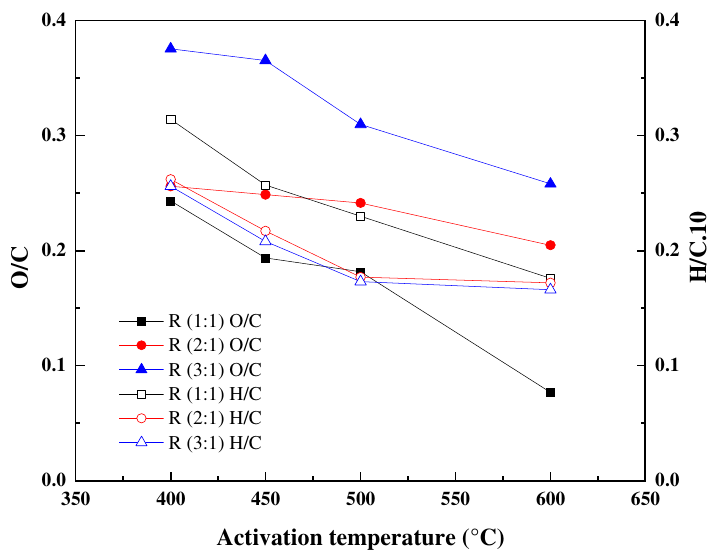
Figure 1. Effect of impregnation ratio and activation temperature on H/C and O/C fractions (H 3 PO 4 concentration: wt. 85%; flow N 2 100 mL/min; activation duration: 1 h).